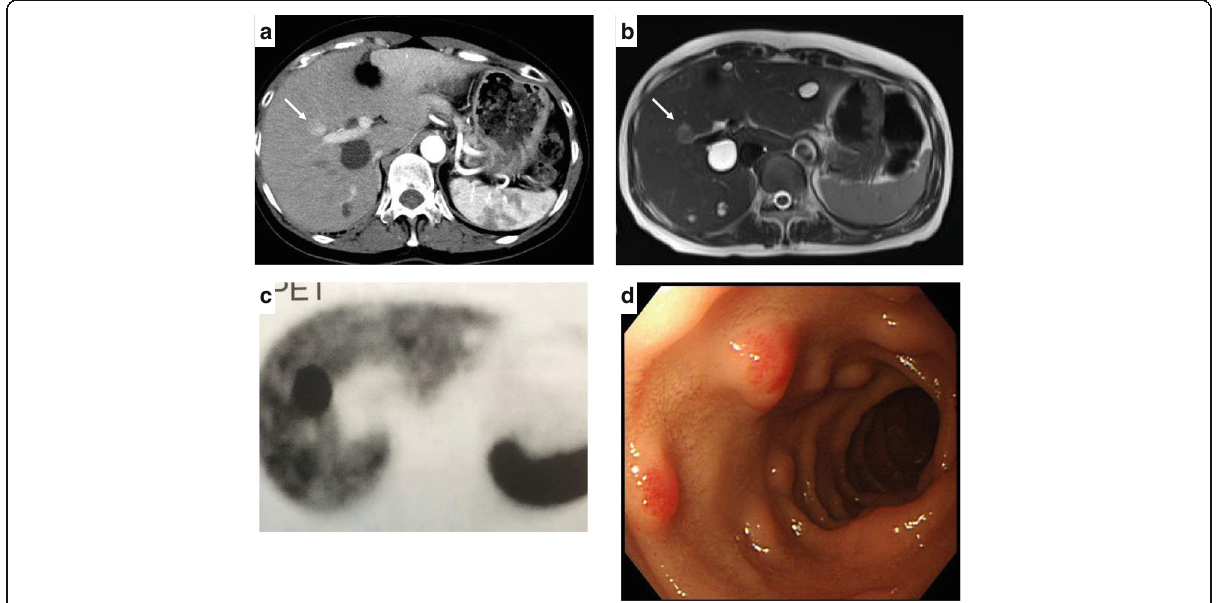
Fig. 1 Preoperative imaging findings. a Abdominal contrast-enhanced computed tomography (CT) showing a hypervascular tumor in the posteroinferior segment of the right hepatic lobe (arrow). b Magnetic resonance imaging (MRI) showing a hypointensity tumor on T2-weighted imaging (arrow). c Somatostatin receptor scintigraphy (SRS) showing abnormal uptakes in the liver mass. d Upper gastrointestinal endoscopy showing several submucosal tumor-like lesions in the first to the second portion of the